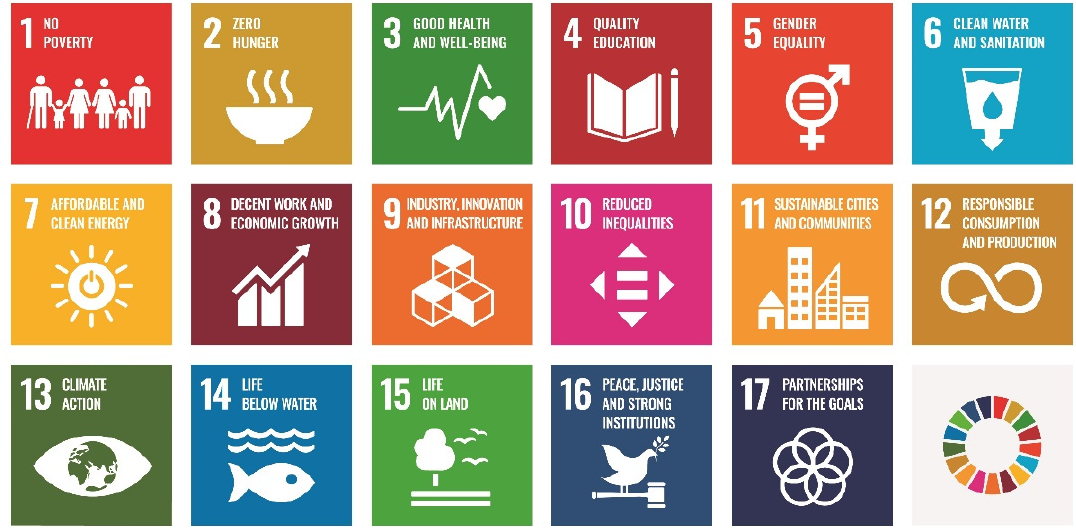
Figure 1. The 17 United Nations Sustainable Development Goals (SDGs) adopted in 2015 as part of the United Nations 2030 Agenda for Sustainable Development. Colors used here to differentiate the various SDGs are used throughout the figures below.